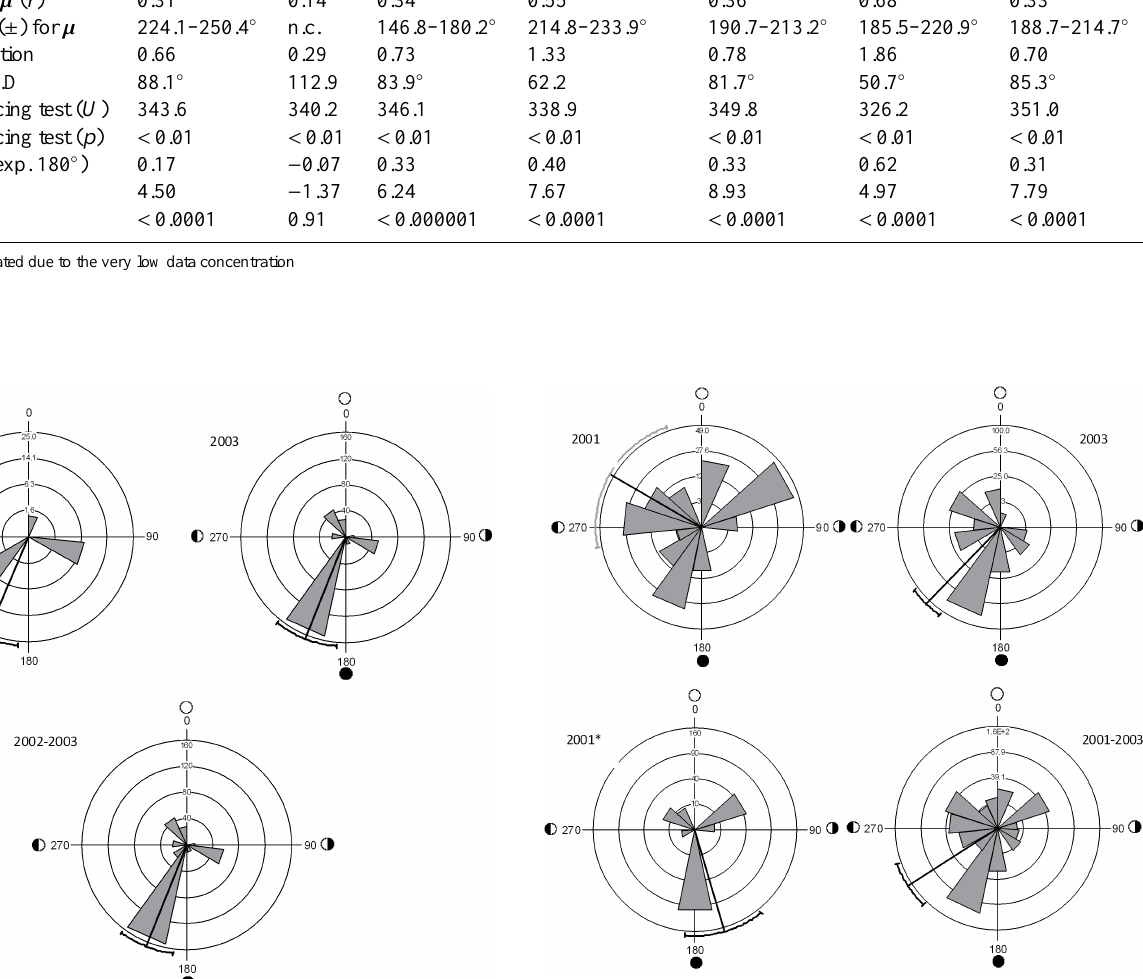
Figure 2. Patterns of reproductive phenology in Hyla intermedia in relation to lunar cycle at the study locality in Mediterranean Central Italy. Datasets from 2002, 2003 and pooled years are shown. Area of wedges represents the number of egg clutches (each one considered a proxy of a single pair in spawning activity) laid during a single night. Concentric dotted lines represent the scale for the number of egg masses (numbers only on the top axis). Black ray indicates the mean vector ( µ ) and the external black curved line represents 95% confident intervals (in grey if the statistic was unreliable). 0 ◦ = full moon; 180 ◦ = new moon.